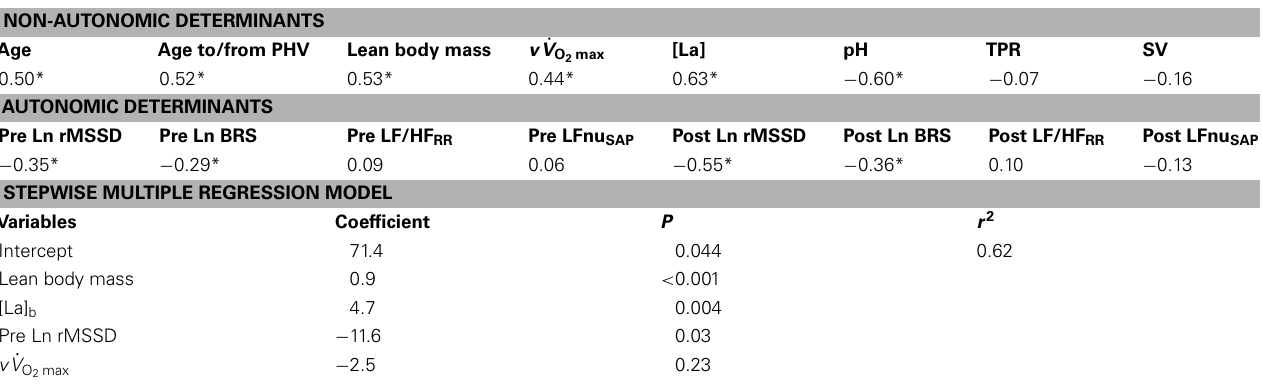
Table 6 | Predictors of the time constant of heart rate recovery using pooled player